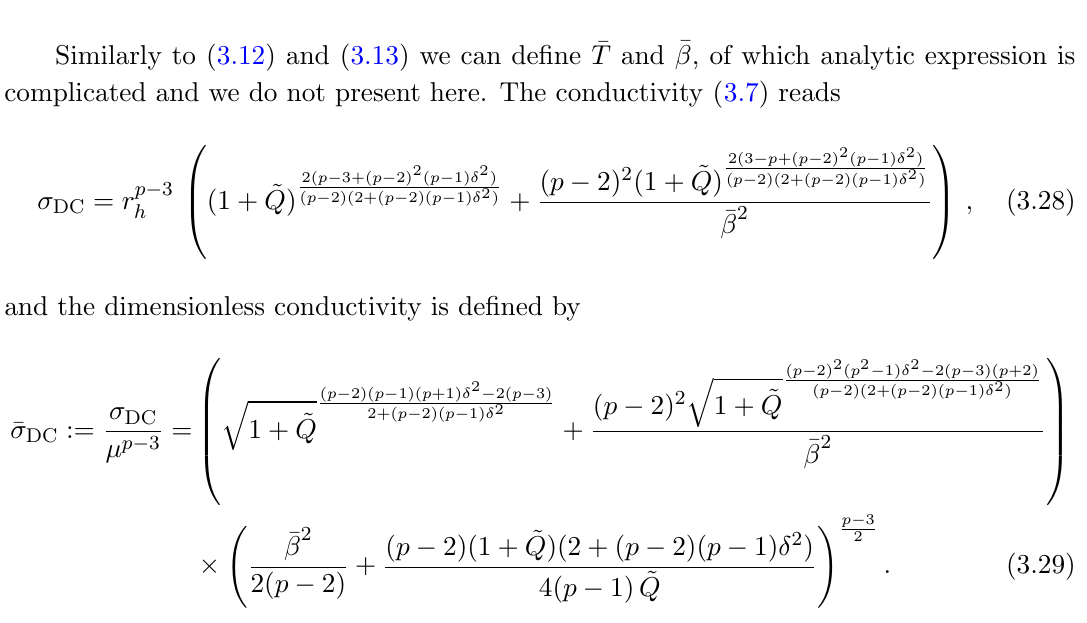
; 55 ; 50 ; 40 ; 30 ; 20 ; 0 (red, orange, yellow, green, blue, purple, 100 100 100 100 100 3